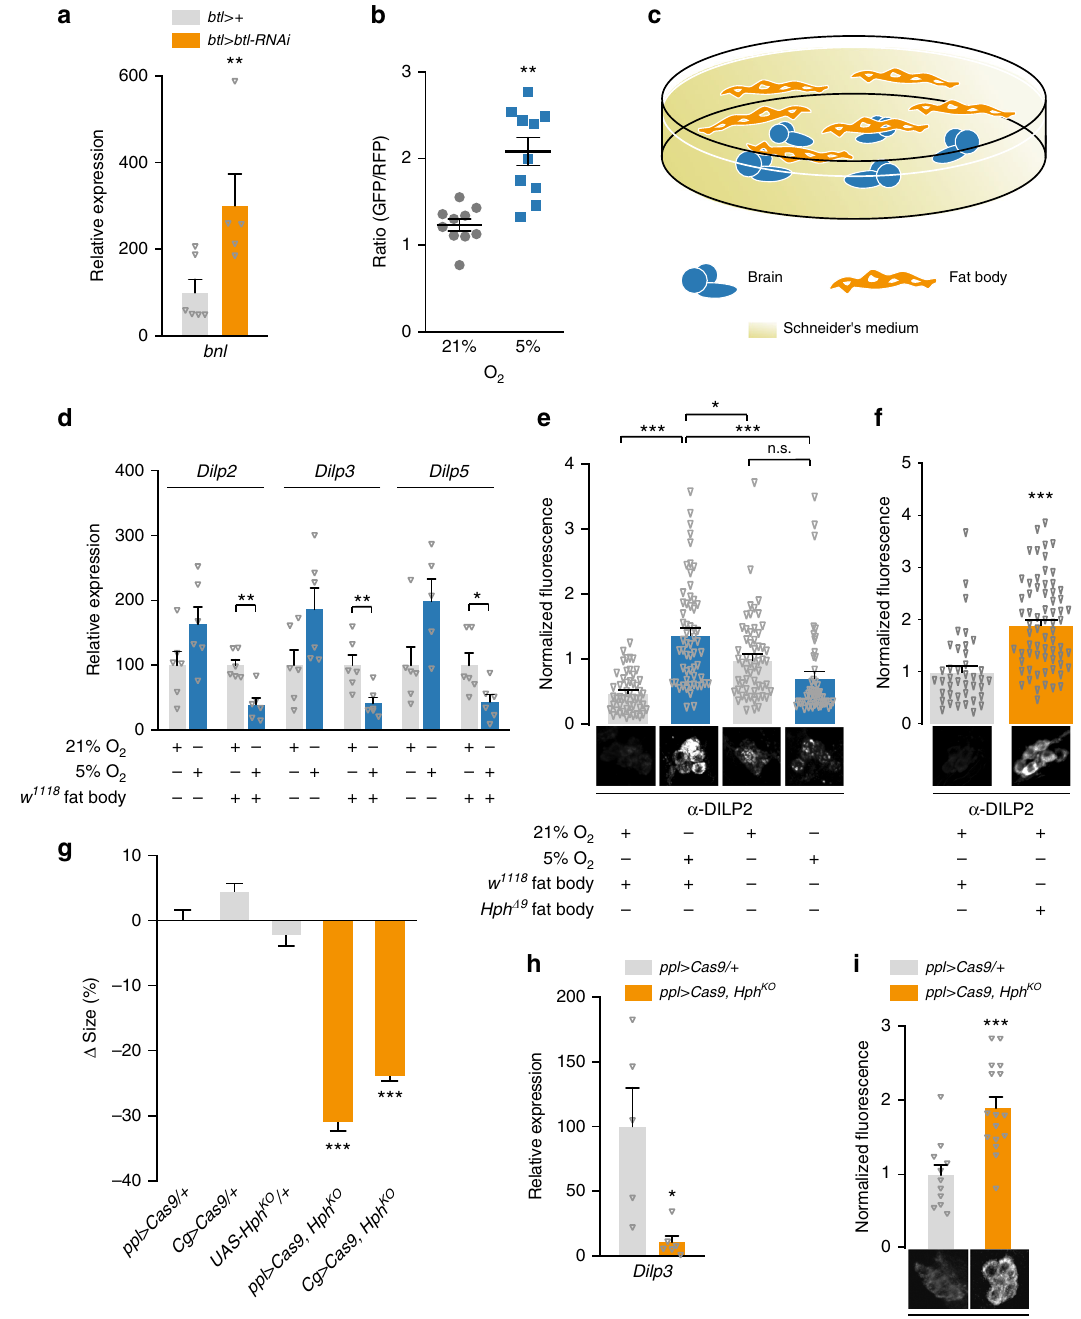
Fig. 6 A fat-body hypoxia sensor represses insulin secretion from the brain. a Transcriptional upregulation of branchless ( bnl ) in the fat body of animals with trachea-speci fi c btl knockdown indicates hypoxia. n = 5 – 6. b A transgenic reporter of hypoxia indicates that the fat body experiences low oxygen levels that inhibit Hph when animals are incubated under 5% O 2 compared with 21% O 2 conditions. Ratio of integrated GFP (carrying the